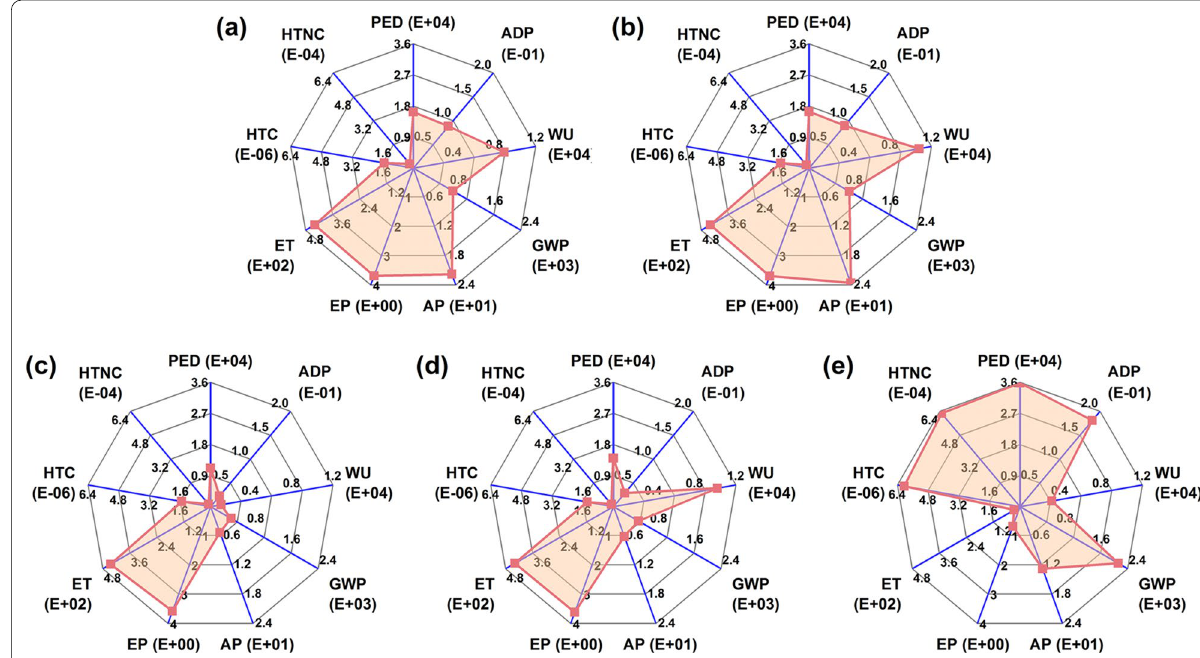
Fig. 4 LCIA results of SR ( a ), SNR ( b ), OSR ( c ), PR ( d ), and CP ( e ) production processes (obtained from the characteristic values shown in Additional file 1: Tables